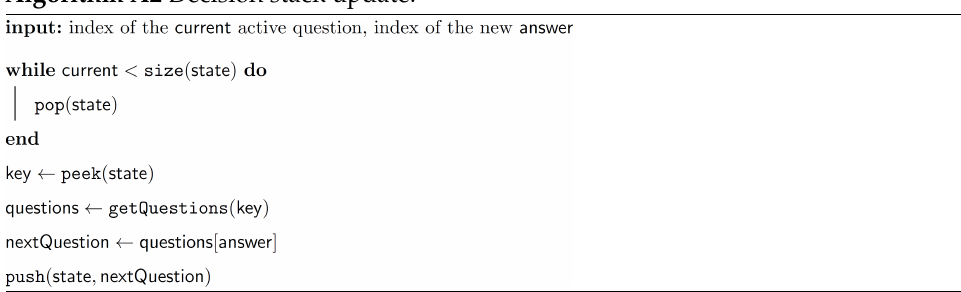
Algorithm A2 Decision stack